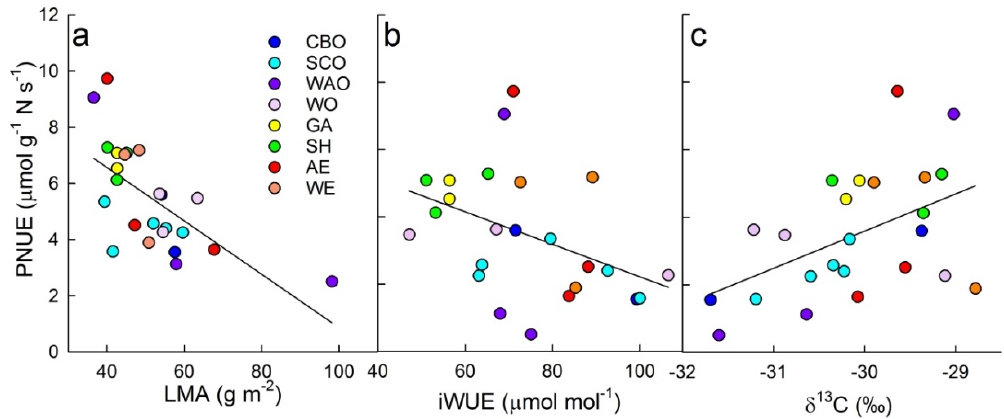
Figure 3. Significant correlations between photosynthetic nitrogen use e ffi ciency (PNUE; µ mol g − 1 N − 1 ) and leaf anatomical and physiological variables including ( a ) leaf mass per unit area (LMA; g m − 2 ), ( b ) intrinsic water use e ffi ciency (iWUE; µ mol mol − 1 ) and ( c ) δ 13 C (% (cid:24) ). Dark blue circles = cherrybark oak (CBO), light blue circles = swamp chestnut oak (SCO), dark purple circles = water oak (WAO), light purple circles = willow oak (WO), yellow circles = green ash (GA) green circles = shagbark hickory (SH), red circles = American elm (AE), orange circles = winged elm (WE).